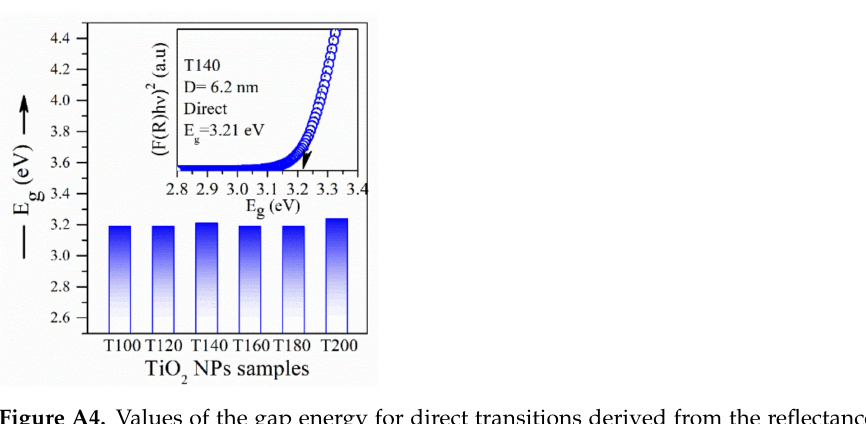
Figure A4. Values of the gap energy for direct transitions derived from the reflectance spectra of all TiO 2 NP samples. Inset: Analyses of the electronic absorption spectrum for T140 assuming direct